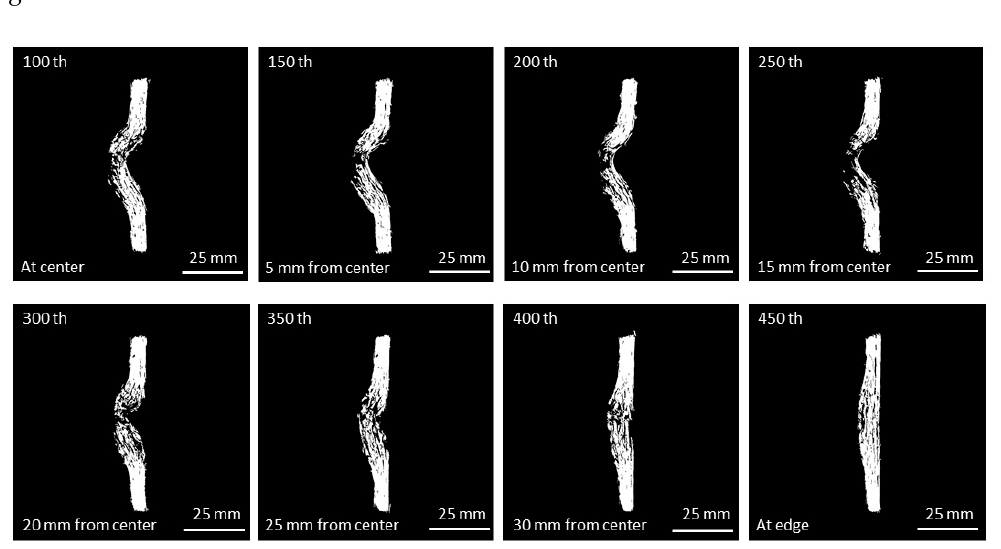
Figure 6. Slices and top view of the carbon fabric reinforced geopolymer composite after impact, a slice of ( a1 – c1 ) longitudinal and ( a2 – c2 ) transverse direction of the damaged area. The lines indicate where the other cross sections were taken. ( d1 – d2 ) Shows the response from the damaged area. The depth of the hole was about half the thickness of the specimen and seemed to be thicker at the center of the impact.